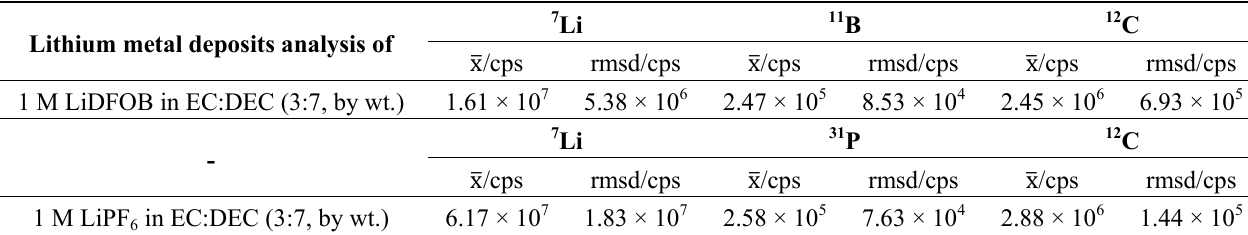
Table 1. Results of chemical composition analysis of the deposition products by LA-ICP-MS technique immediately after lithium deposition onto a copper foil. Lithium was deposited for 360 s at a current density of 1 mA cm − 2 . 7 Li 11 B 12 C Lithium metal deposits analysis of x(cid:3364)